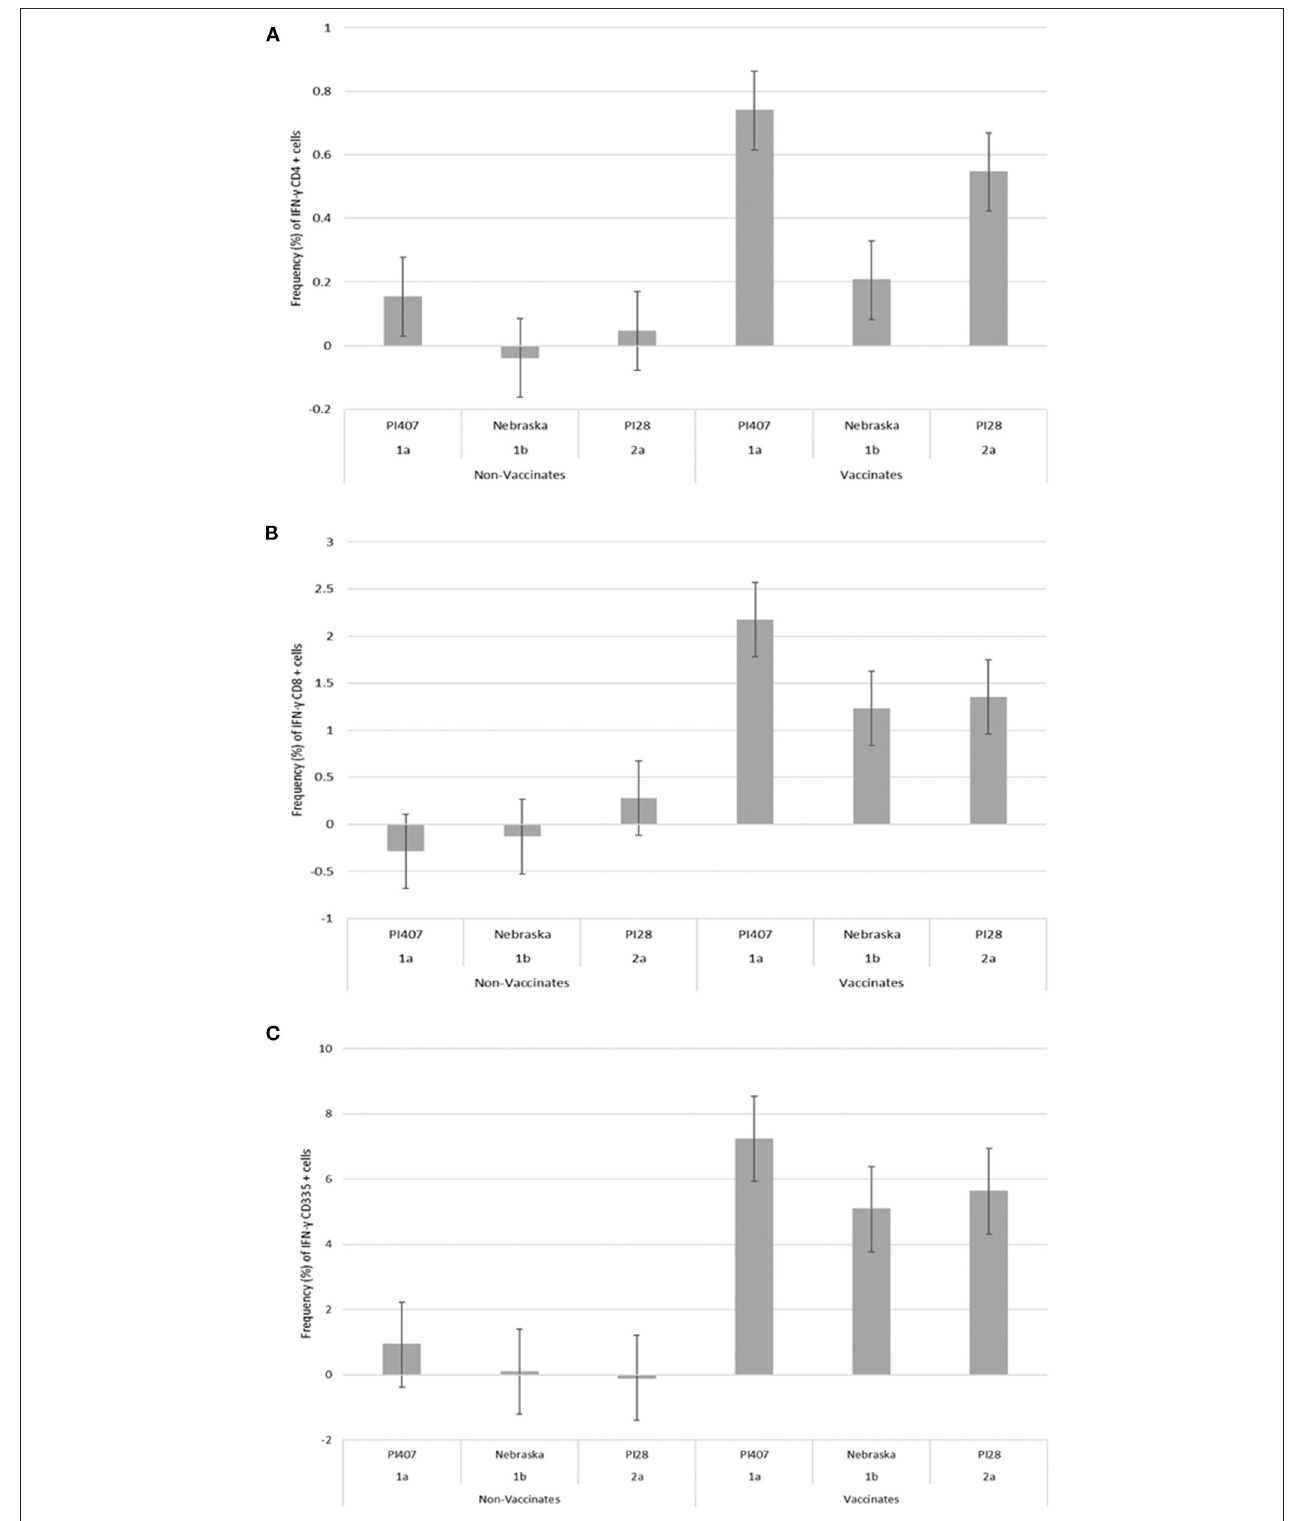
FIGURE 3 | Percent positive cells for each respective PBMC subset (A) CD4 + , (B) CD8 + , (C) CD335 + for IFN- γ mRNA expression in Group 2 vaccinated and non-vaccinated calves at ∼ 12 weeks post-initial vaccination and stimulated with three different BVDV strains (PI407 BVDV-1a, Nebraska BVDV-1b, and PI28